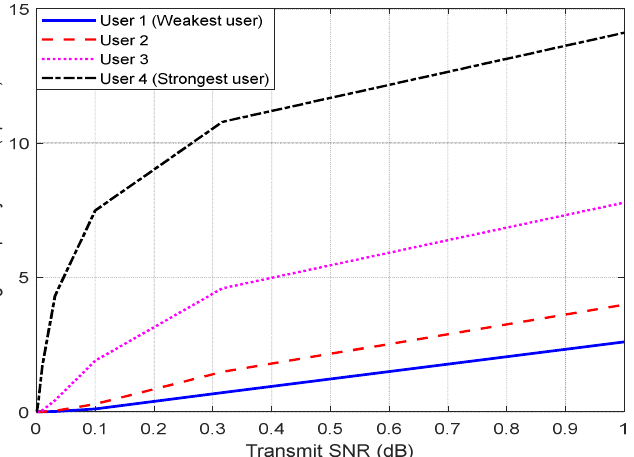
Figure 11. Average capacity rate vs. SNR for four users with varying distances and BW 80 MHz for UL NOMA.